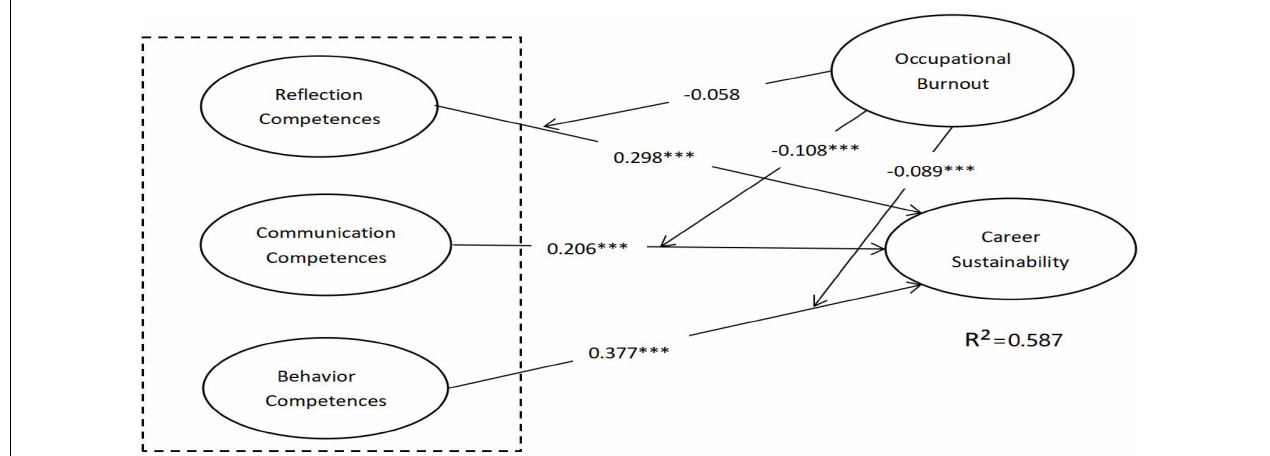
FIGURE 2 | Partial least square (PLS) results of the research model. ∗∗∗ t >